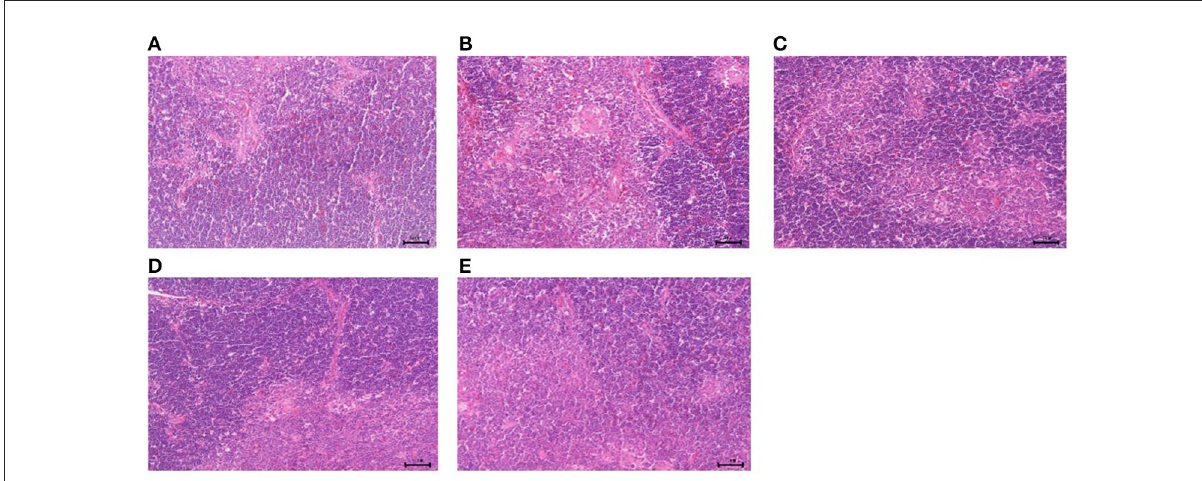
FIGURE10 Histological changes of the thymus in each group. (A) GPS-1L group; (B) GPS-1M group; (C) GPS-1H group; (D) VC group; (E) BC group. H&E staining; 200 × magnification.